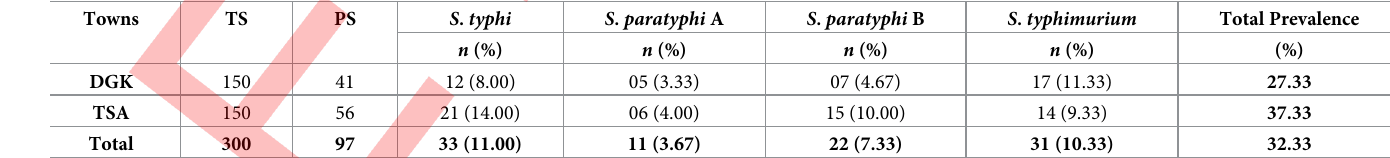
Total 300 32.33 Towns; DGK: D.G. Khan, TSA: Taunsa Sharif. TS; Total number of samples, PS; Total number of positive sample, n = Number of positive samples of respective spp; χ 2(df = 1, α = 0.05) = 1.5466 at p value = 0.2137 for towns; χ 2(df = 3, α = 0.05) = 4.1571 at p value = 0.2450 for Salmonella